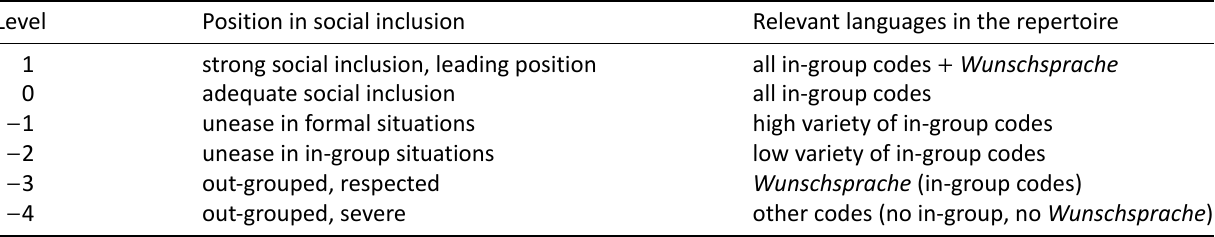
Table 1. The scale of linguistic unease and social inclusion in European contexts. Level Position in social inclusion Relevant languages in the